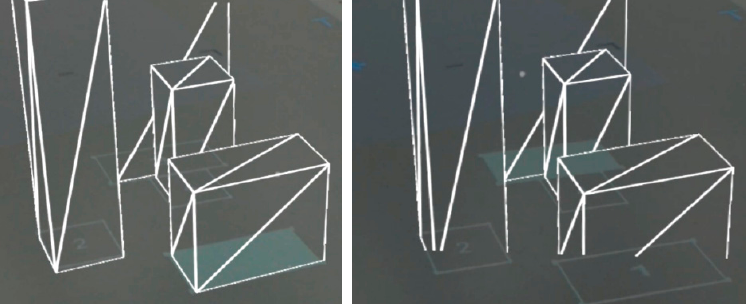
Figure 15. Selecting the front object one ( left ) and object four at rear ( right ). Cropping of the HMD FOV is visible given the clipping of the bottom of the boxes on the right image.